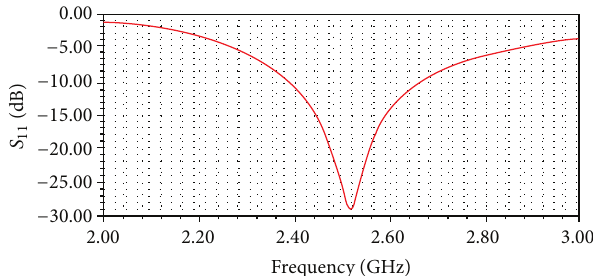
Figure 2: Simulated return loss for the proposed printed dipole